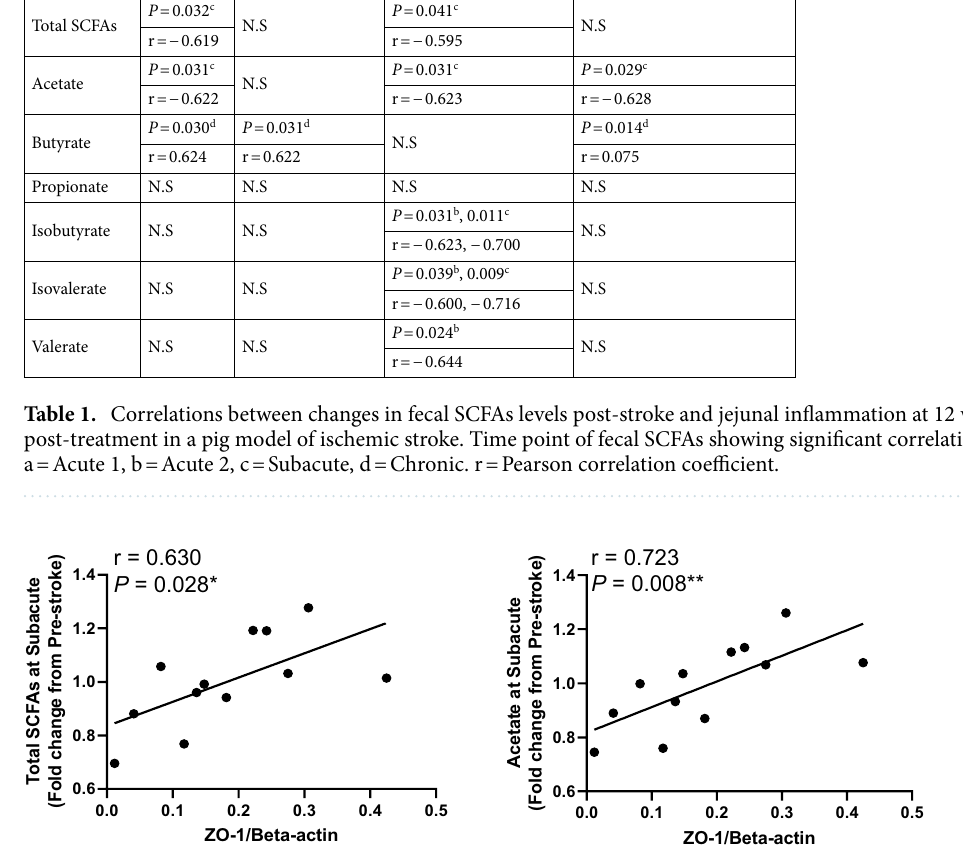
Figure 3. Total SCFAs and acetate levels at the subacute stage were positively correlated with ZO-1 protein expression in the jejunal mucosa at 12 weeks post-treatment. Fecal total SCFAs and acetate levels at the subacute was positively correlated with ZO-1 protein expression at 12 weeks PT (All P < 0.05). r = Pearson correlation coefficient and P values are shown. * P < 0.05, ** P <